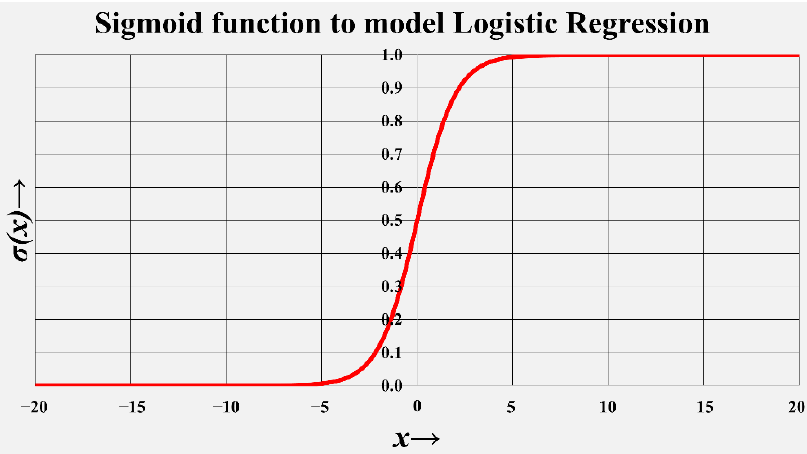
Figure 3. Sigmoid function to model logistic regression ML model.